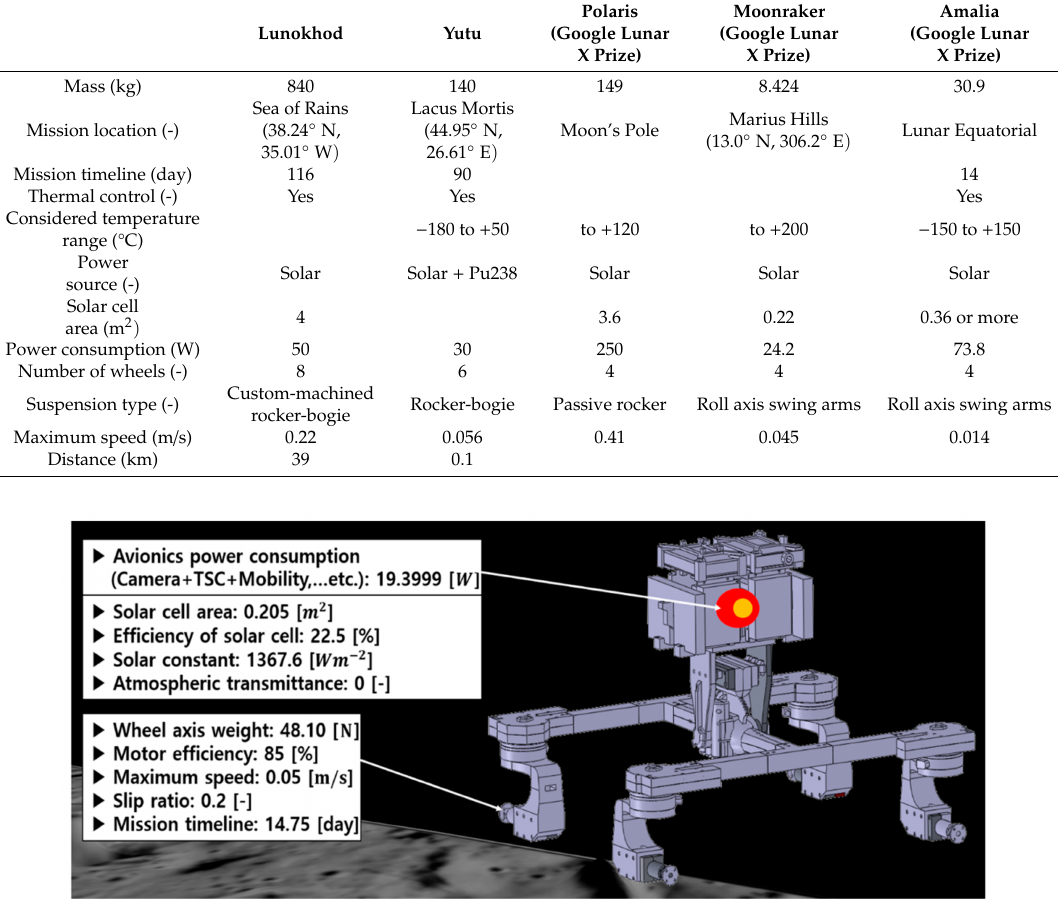
Figure 7. System-level requirements for the Korean solar-powered exploration